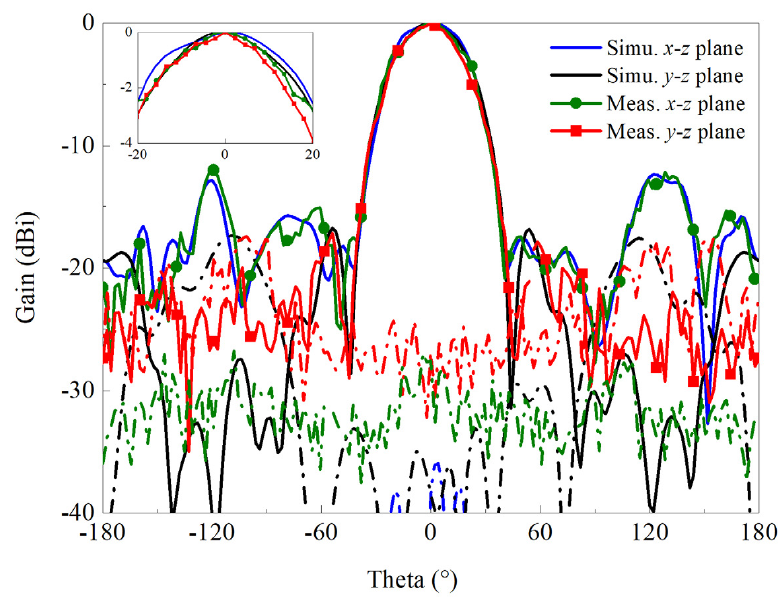
Figure 15. Simulated and measured normalized radiation patterns at 24 GHz.